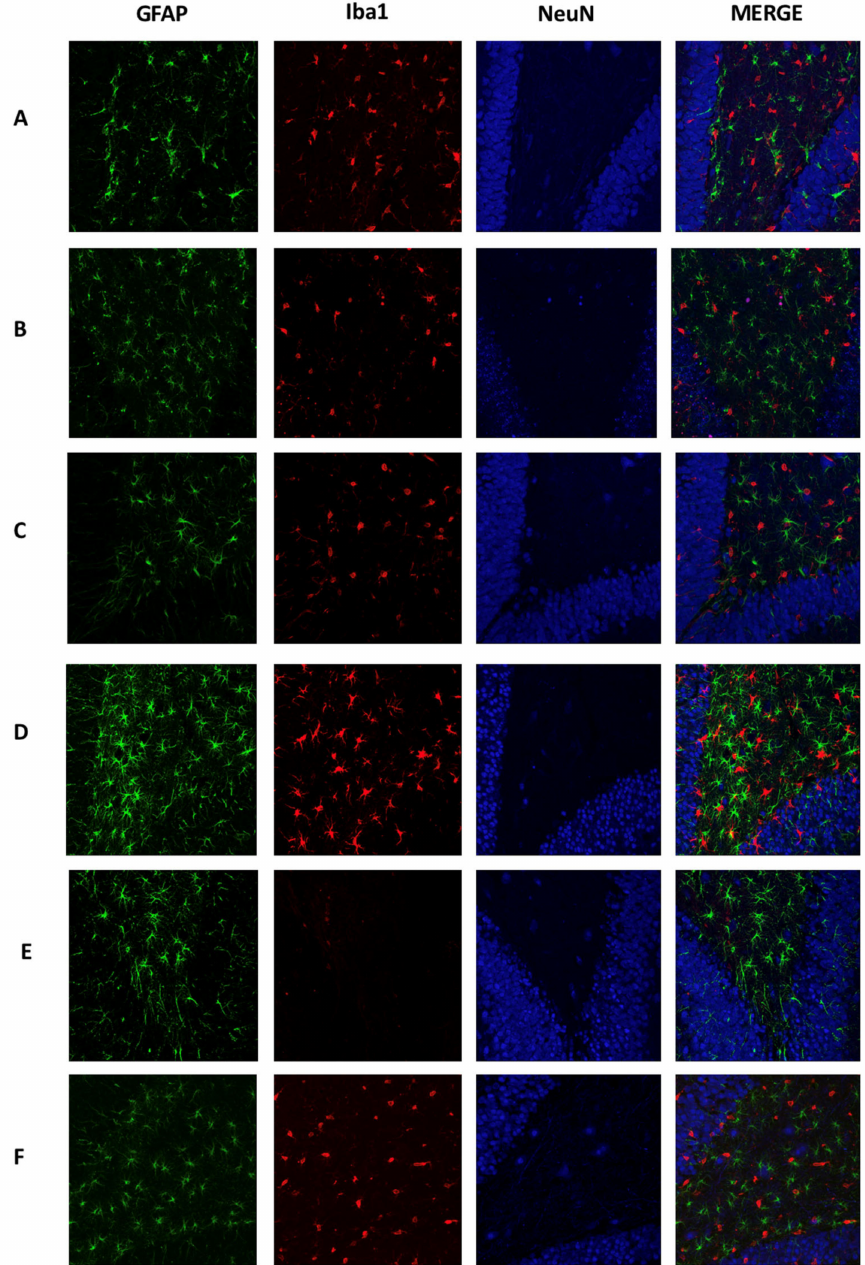
Figure 4. Chronic cellular response mediated by A β O. Brain sections were immunolabeled to detect mature neurons (Anti-Neun, Cy5), astrocytes (Anti-GFAP, Alexa 488), and microglia cells (Anti-Iba, Alexa 555). Representative 40 × images of DG show cellular response in the groups: ( A ) SS 7 d, (B) A β 7 d, ( C )SS 15 d, ( D ) A β 15 d, ( E ) SS 30 d, and ( F ) A β 30 d. Hypertrophic astrocytes were higher in A β O-injected rats ( B , C , and D ) with concomitant activation of microglial cells and a reduction of the neuronal density in